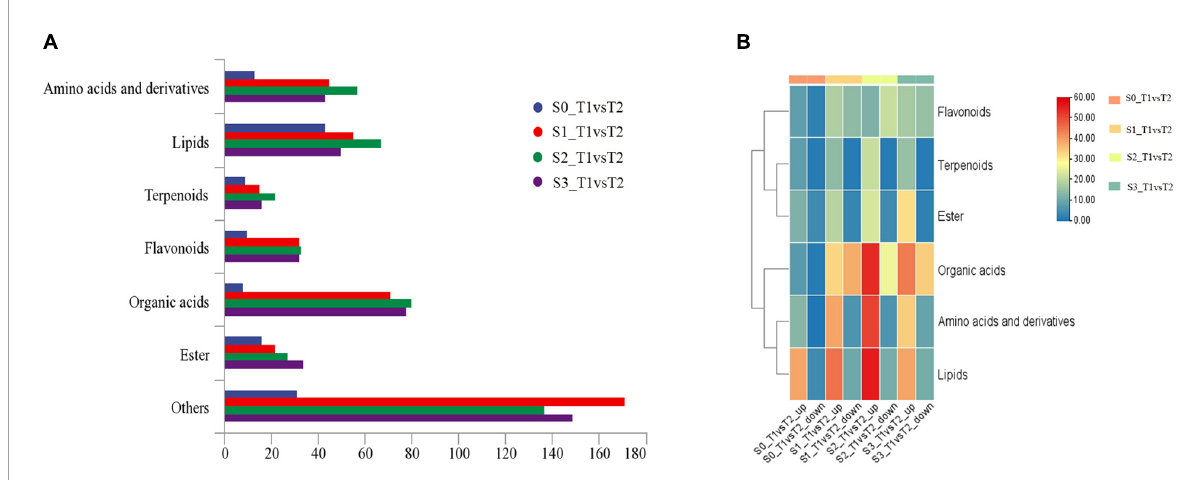
FIGURE5 (A) Column chart of metabolites in fermented rapeseed cake in four stages. (B) Cluster heat map of metabolites in fermented rapeseed cake in four stages.